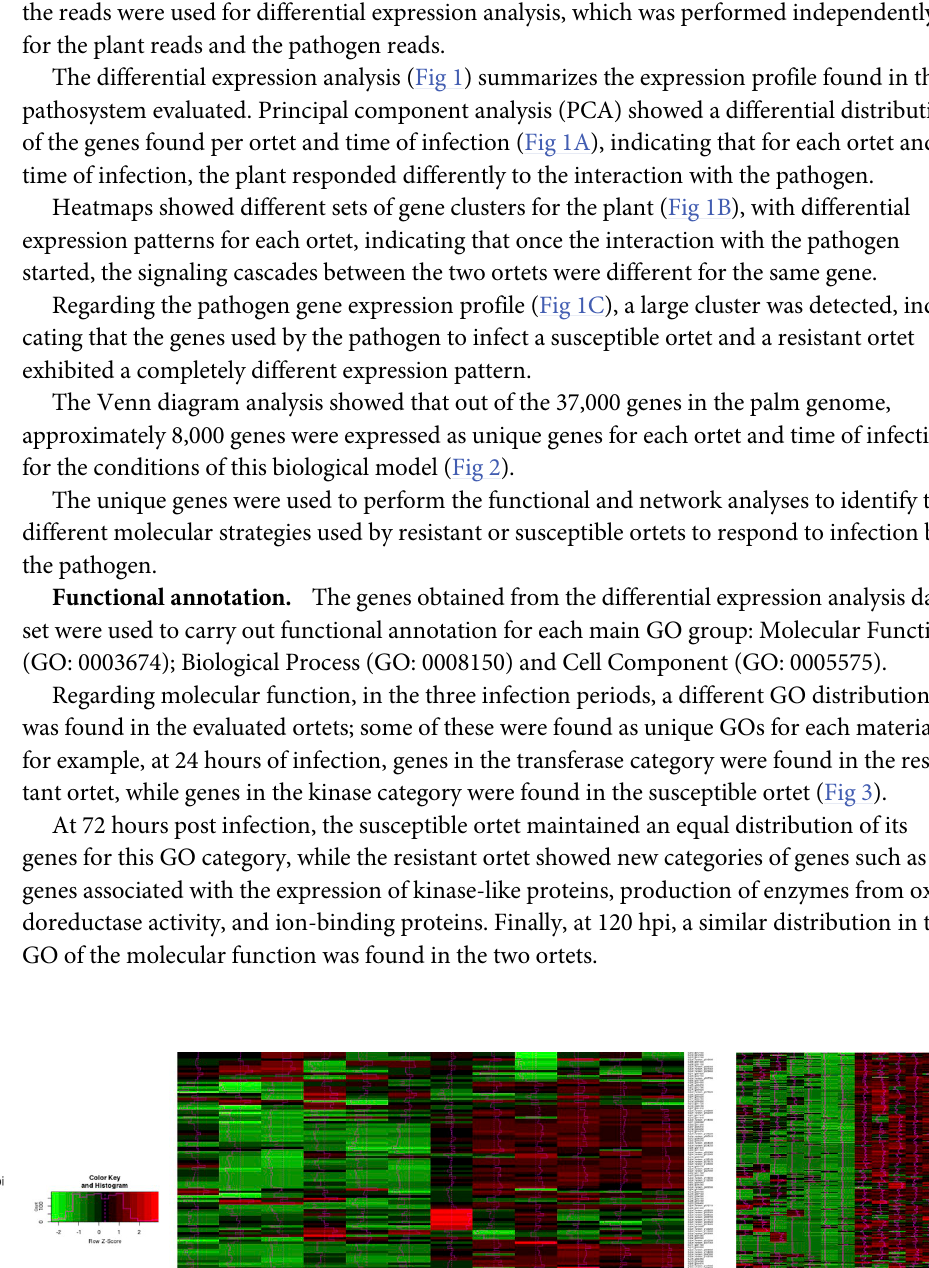
PLOS ONE | https://doi.org/10.1371/journal.pone.0222774 September 25,